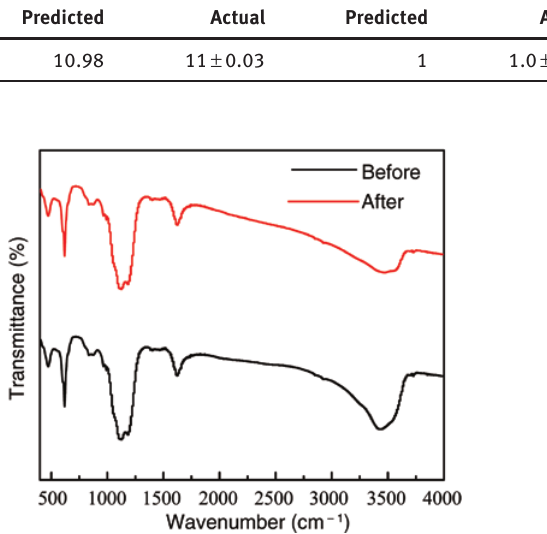
Figure 9: The comparison of infrared spectrum of zinc oxide leach residues before and after